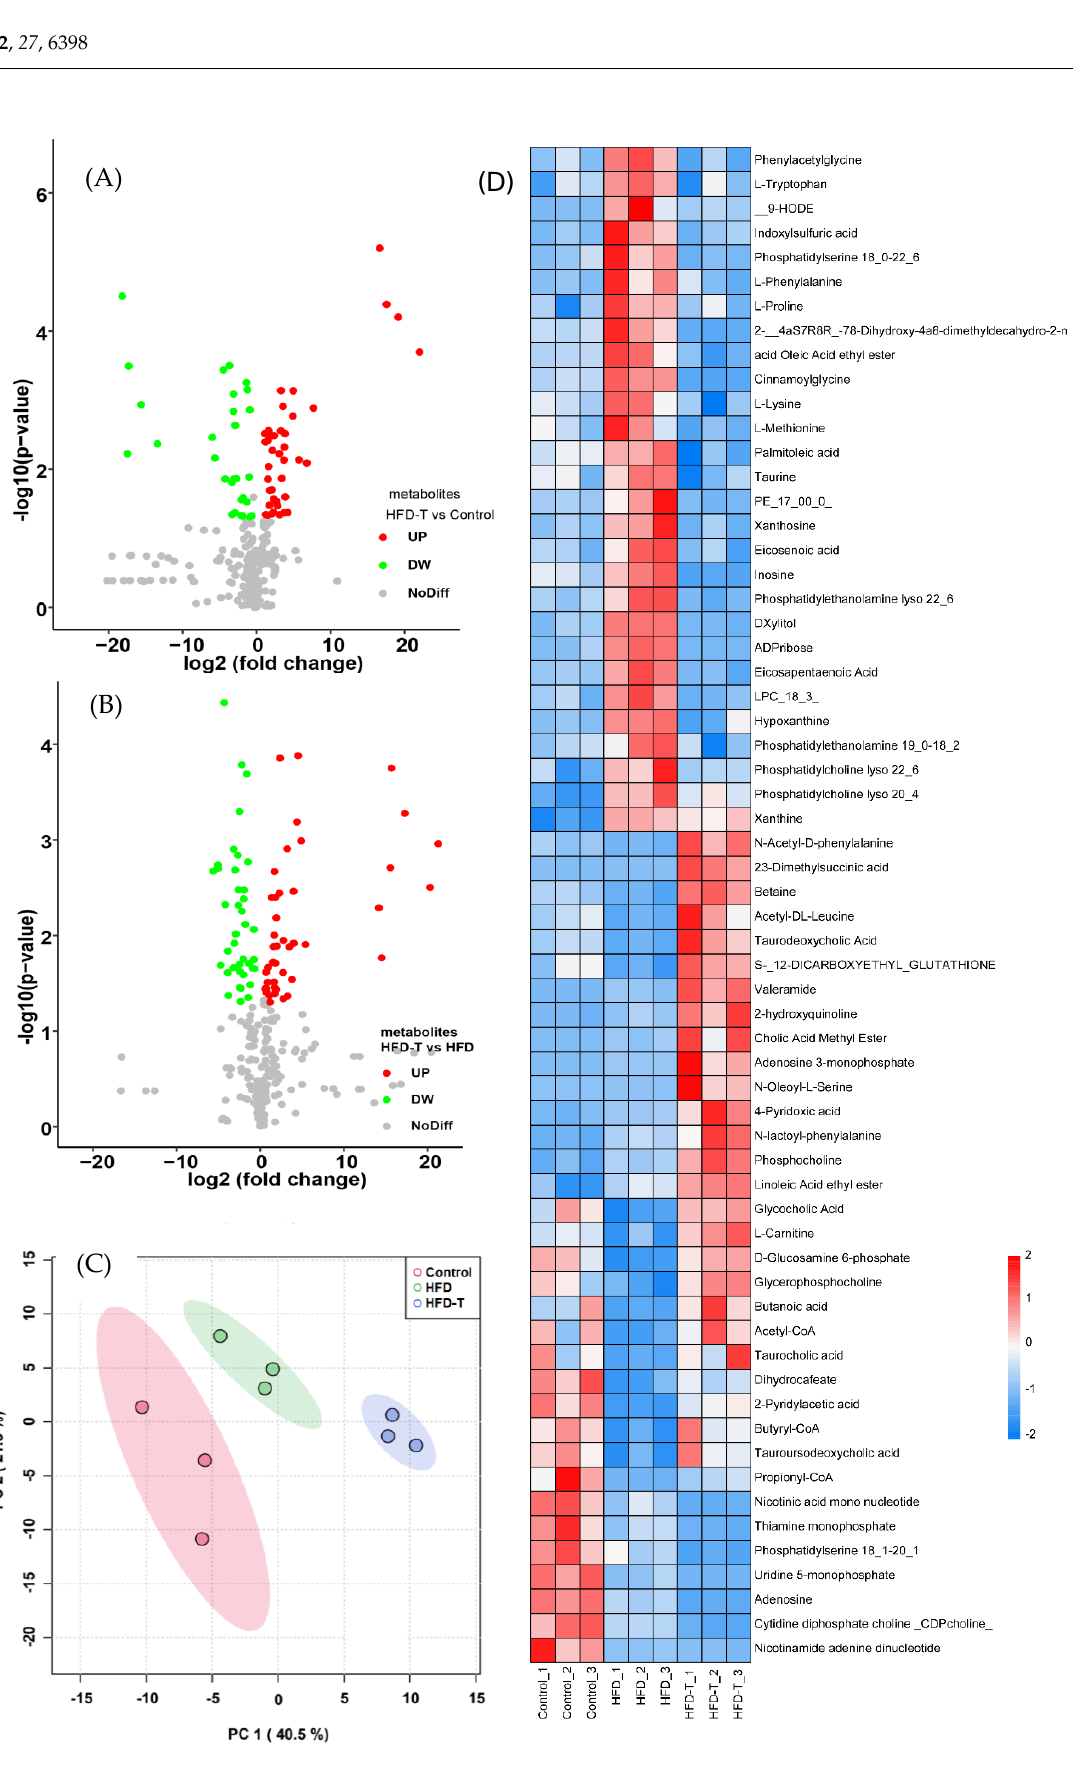
Figure 5. The volcano plot of metabolites ( A , B ) and the PCA analysis ( C ) under different treatment or diet as well as the heatmap of metabolites ( D